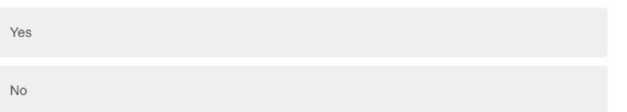
Figure 4. Qualtrics question examining SIRVA diagnostic criteria, specific to neurological injuries.